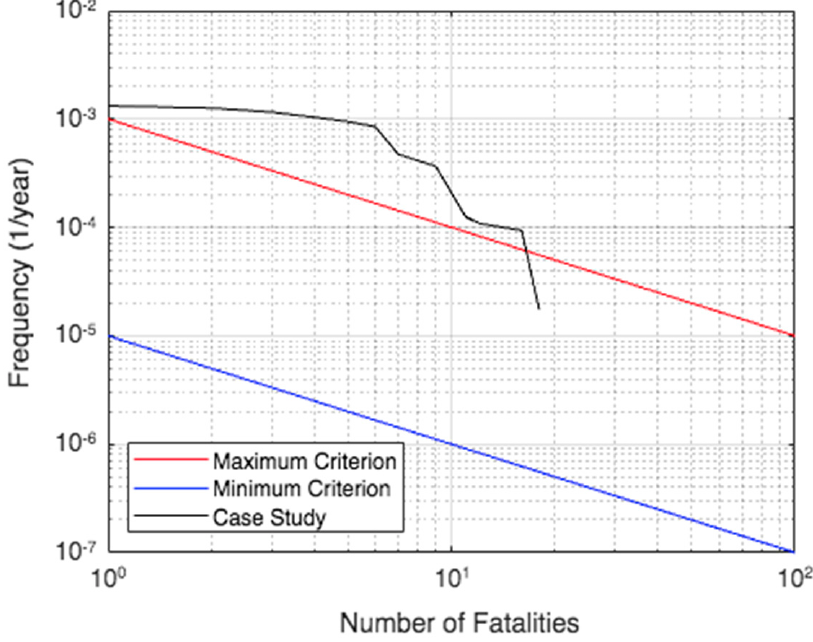
Figure 4. F − N curve and acceptability criteria ( calculated using the procedure described in [36]).